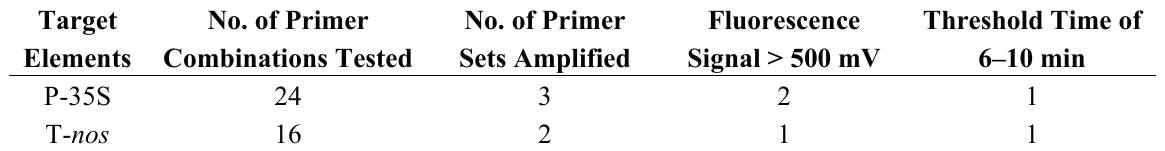
Table 1. Primer screening results.